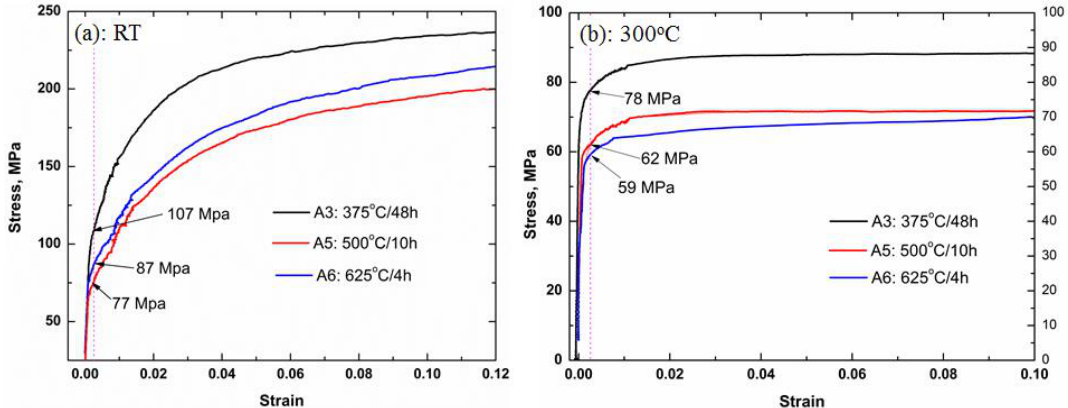
Figure 5. True strain-stress curves of alloy after A3, A5, and A6 at both RT ( a ) and 300°C ( b ). Table 3. YS and EC after various heat treatments.